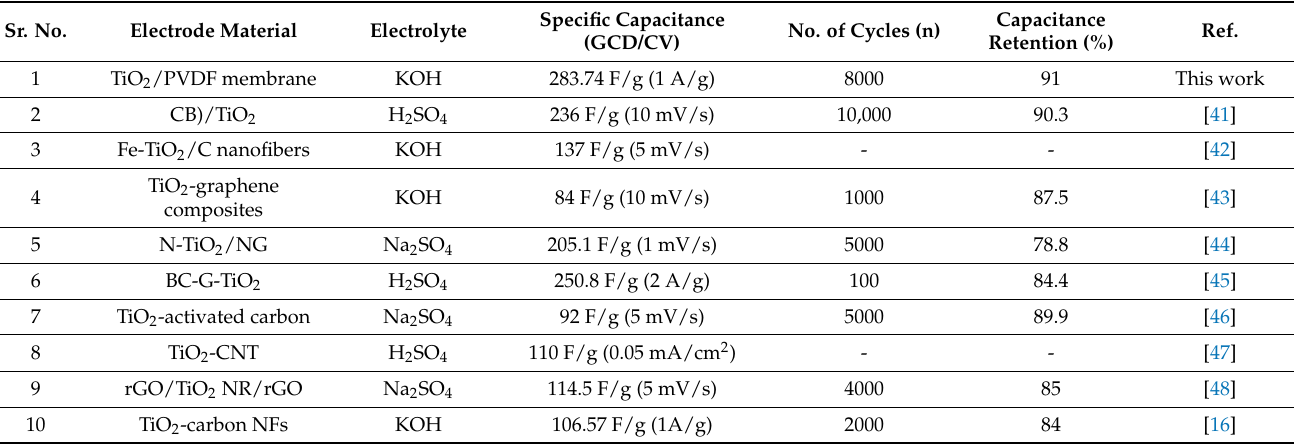
Table 1. A comparison table of the electrochemical performance of previously published works with the as-prepared TiO 2 /PVDF membrane for supercapacitor